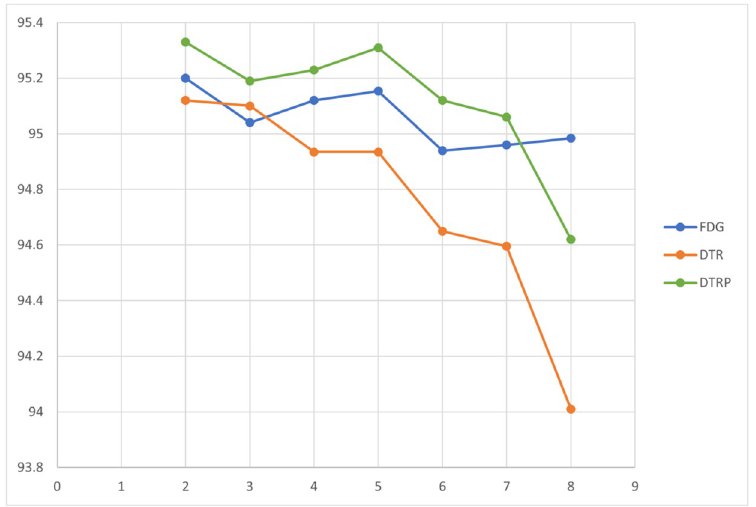
Fig 8. Top-1 accuracy of ResNet18 using different